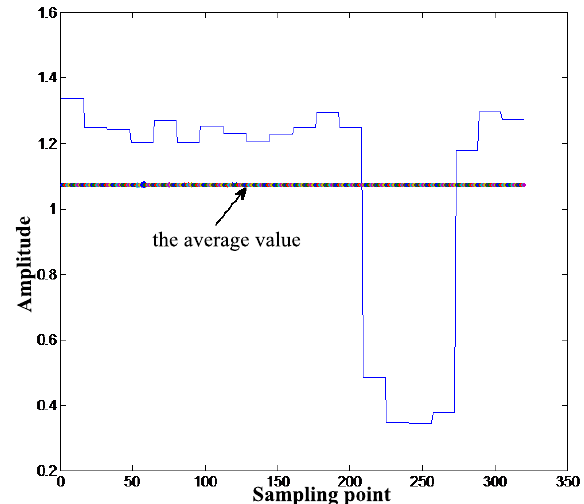
Figure 3. The characteristic curve of y acc sequence after the wavelet